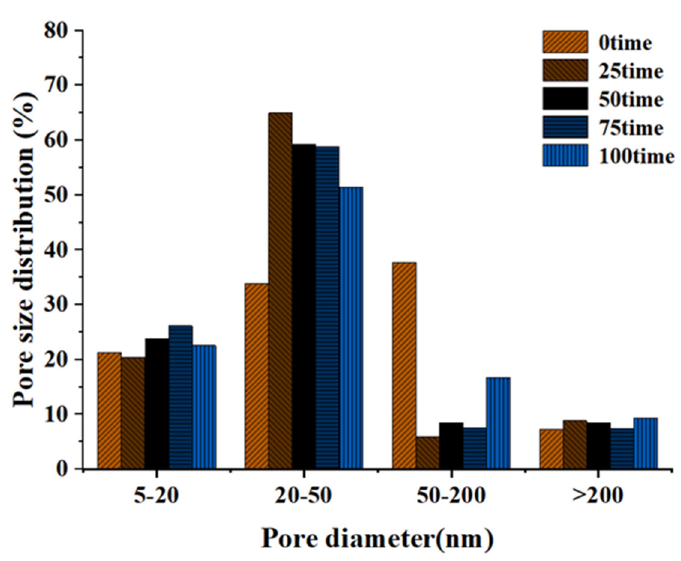
Figure 14. Pore size distribution of cement paste under freeze-thaw cycles.